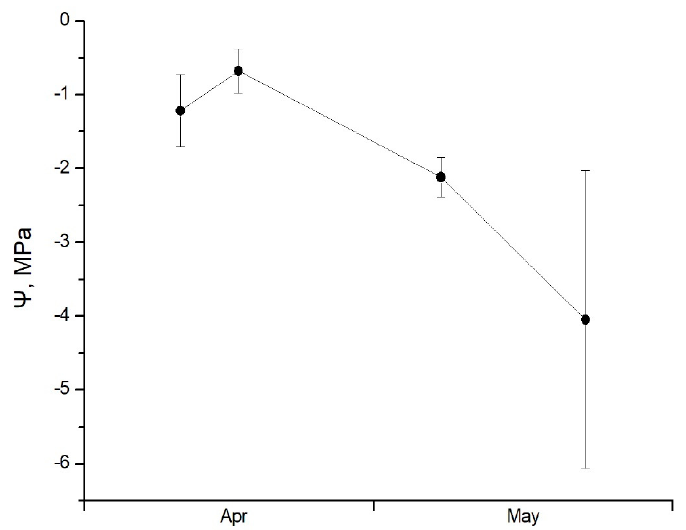
Figure 8. Seasonal fluctuation of water potential ( Ψ ). Each point corresponds to the mean from six measurements (one measurement per plot) ± standard deviation.